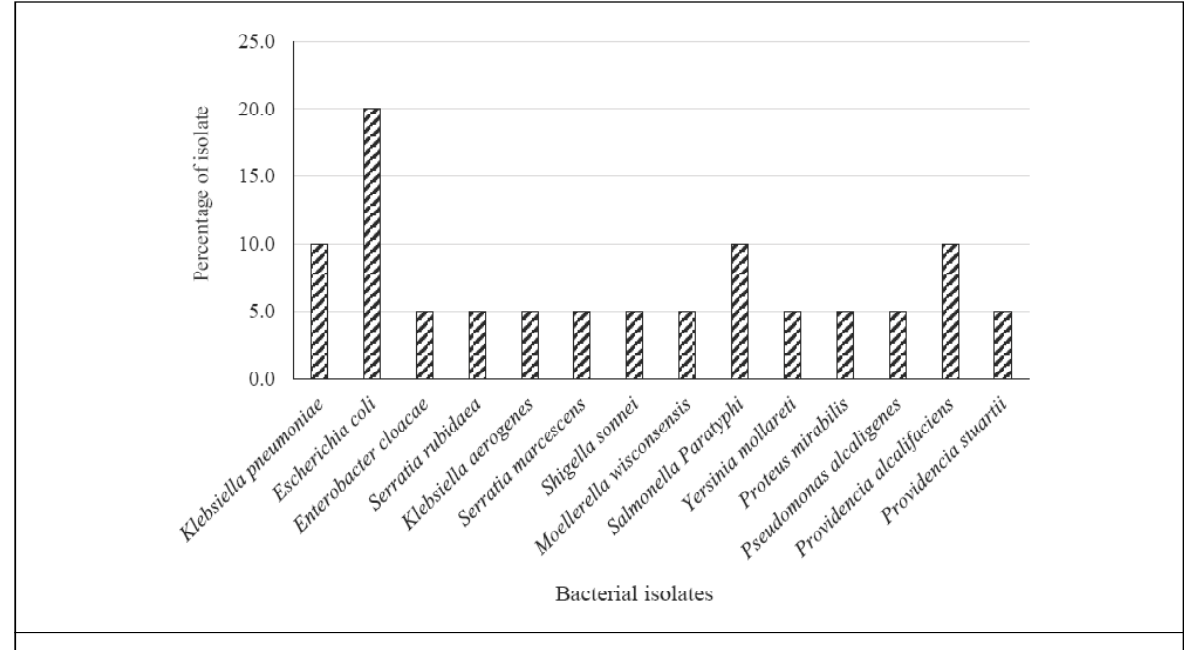
Figure 2: Bacteria isolates from ATMs